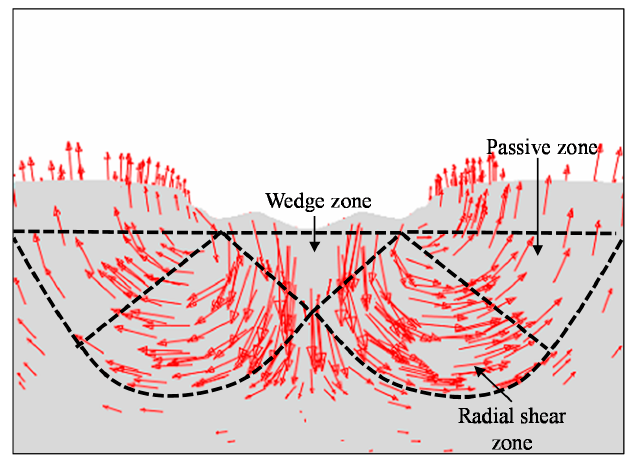
Figure 9. Instantaneous velocity plots.